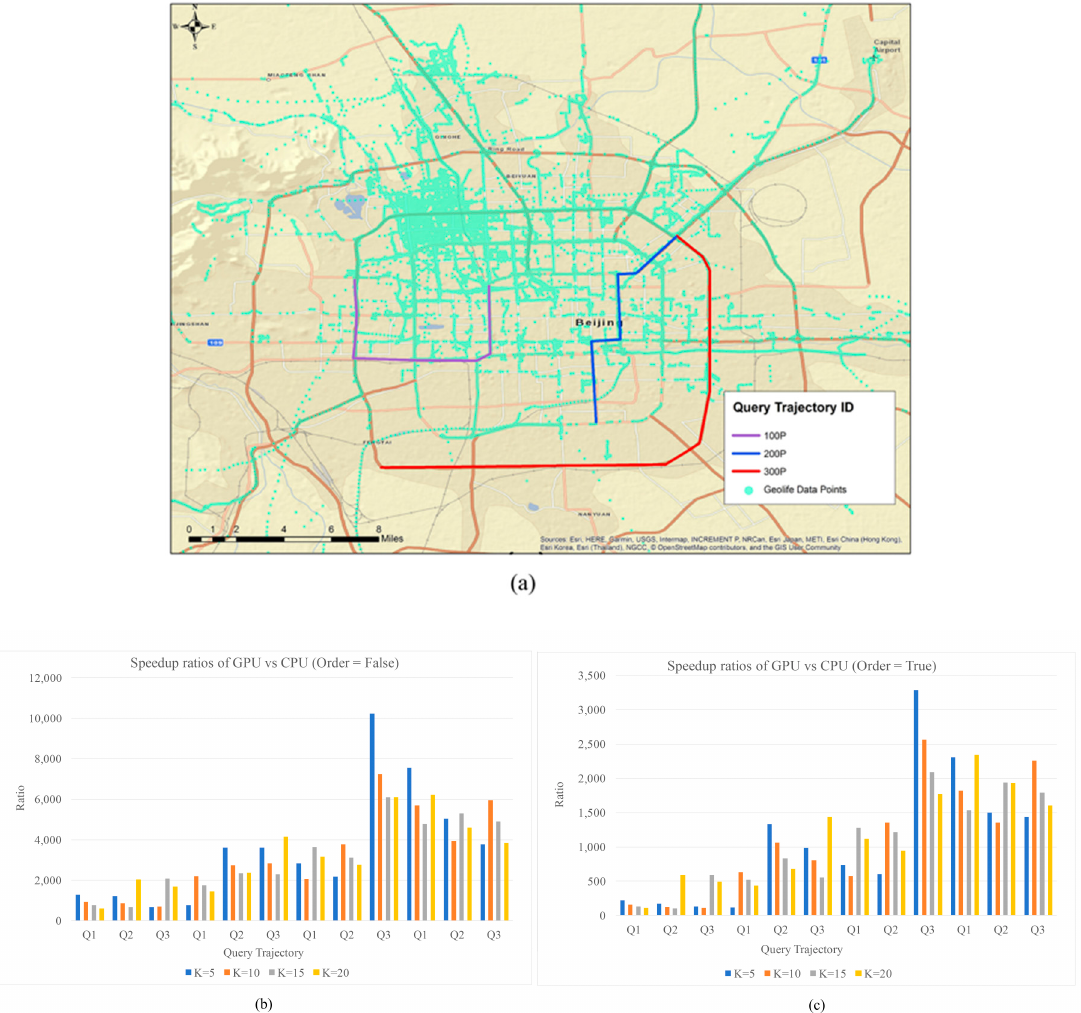
Figure 6. ( a ) Distribution of GeoLife query trajectories and reference trajectories data; ( b ) speedup ratios when there is no order constraint; ( c ) speedup ratios when there is order constraint.